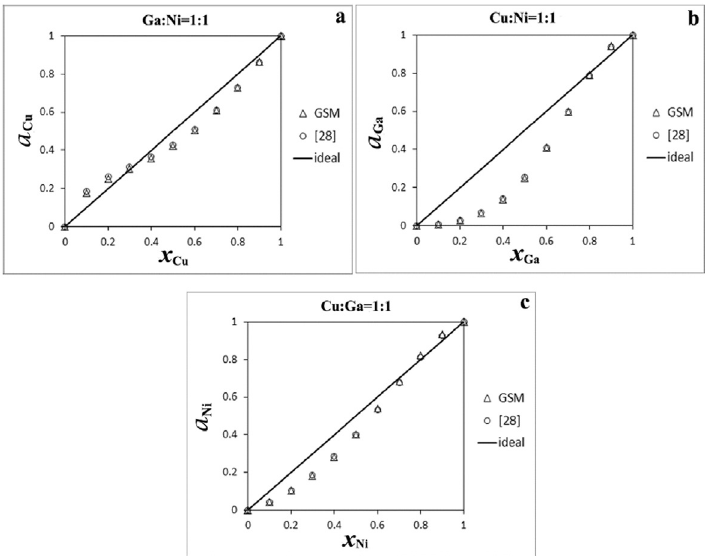
Figure 5: Dependence of copper (a), gallium (b) and nickel (c) activities from composition at 1773 K, predicted according to GSM, compared with literature data 28 .